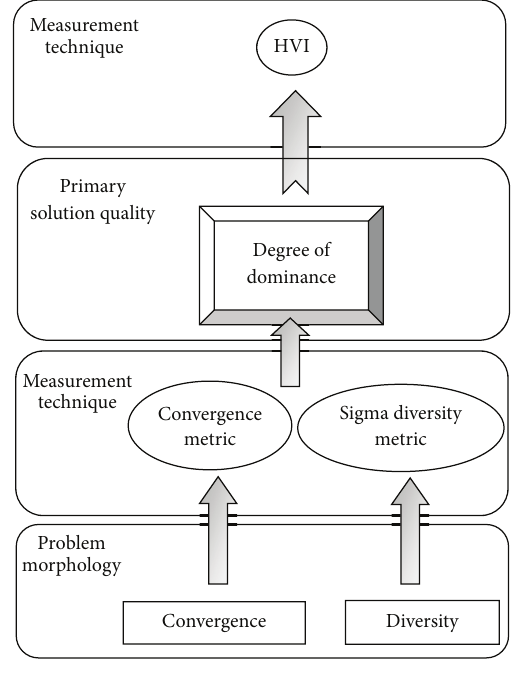
Figure 1: Hierarchy